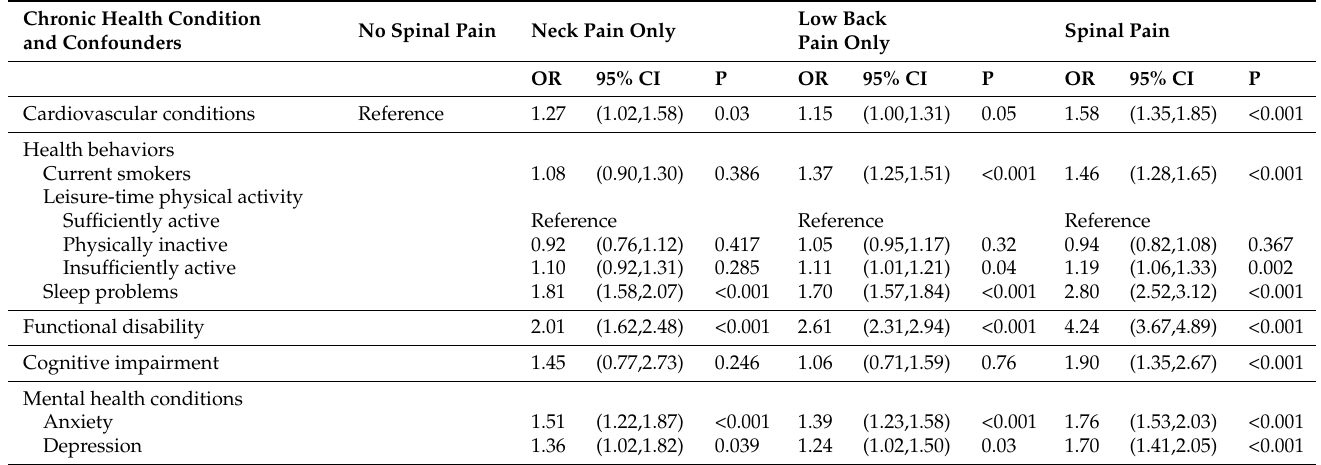
Table 2. The associations between cardiovascular conditions and spinal pain variables in the US adult population, 2016–2018 *.